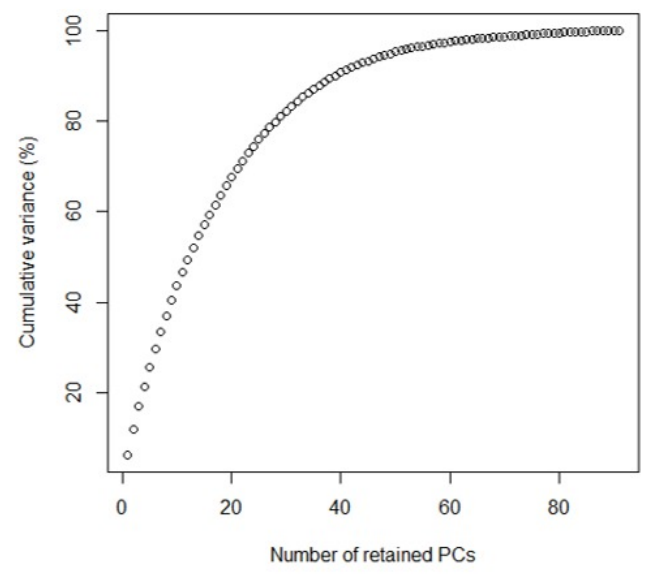
Figure 9. Graph of cumulated variance. Variance explained by PCA.